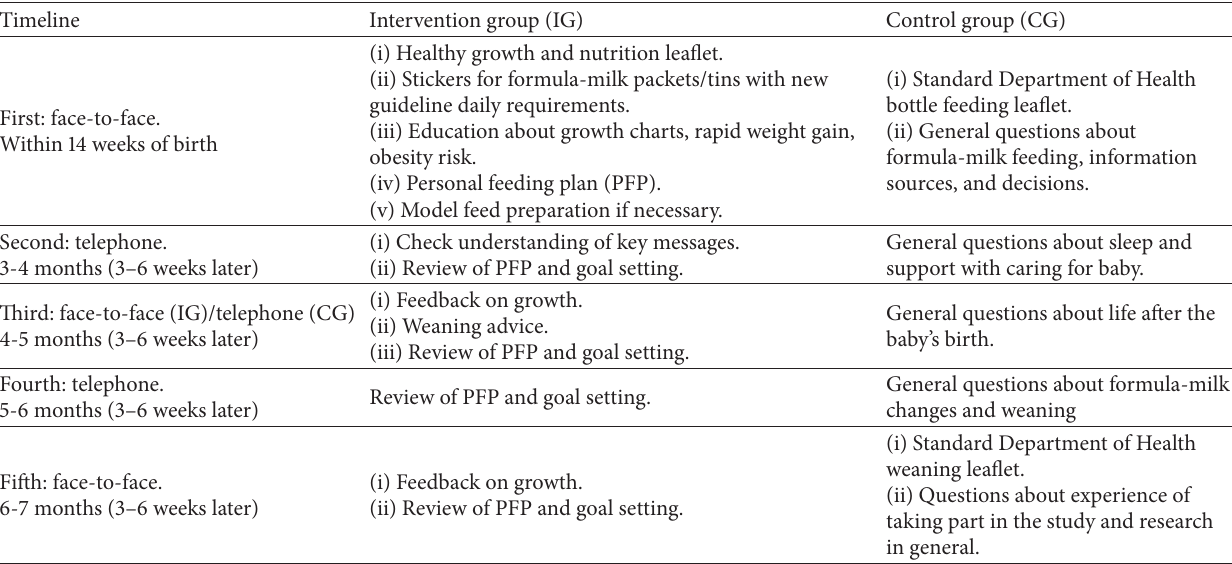
Table 3: Intervention and Control contacts and